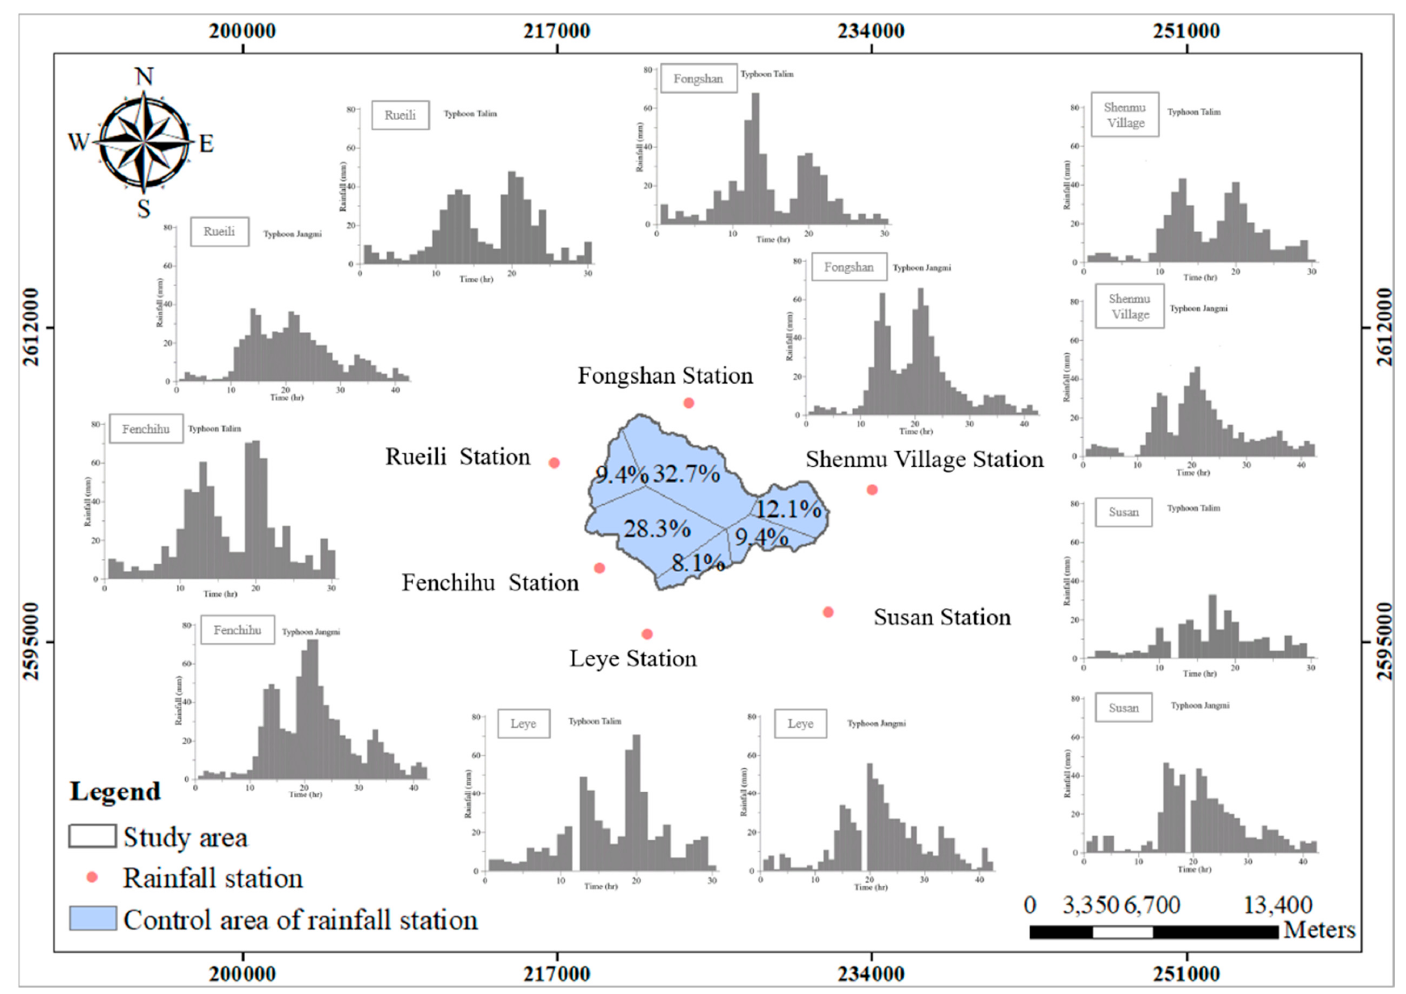
Figure 3. Control area and rainfall hyetograph of each rainfall station.